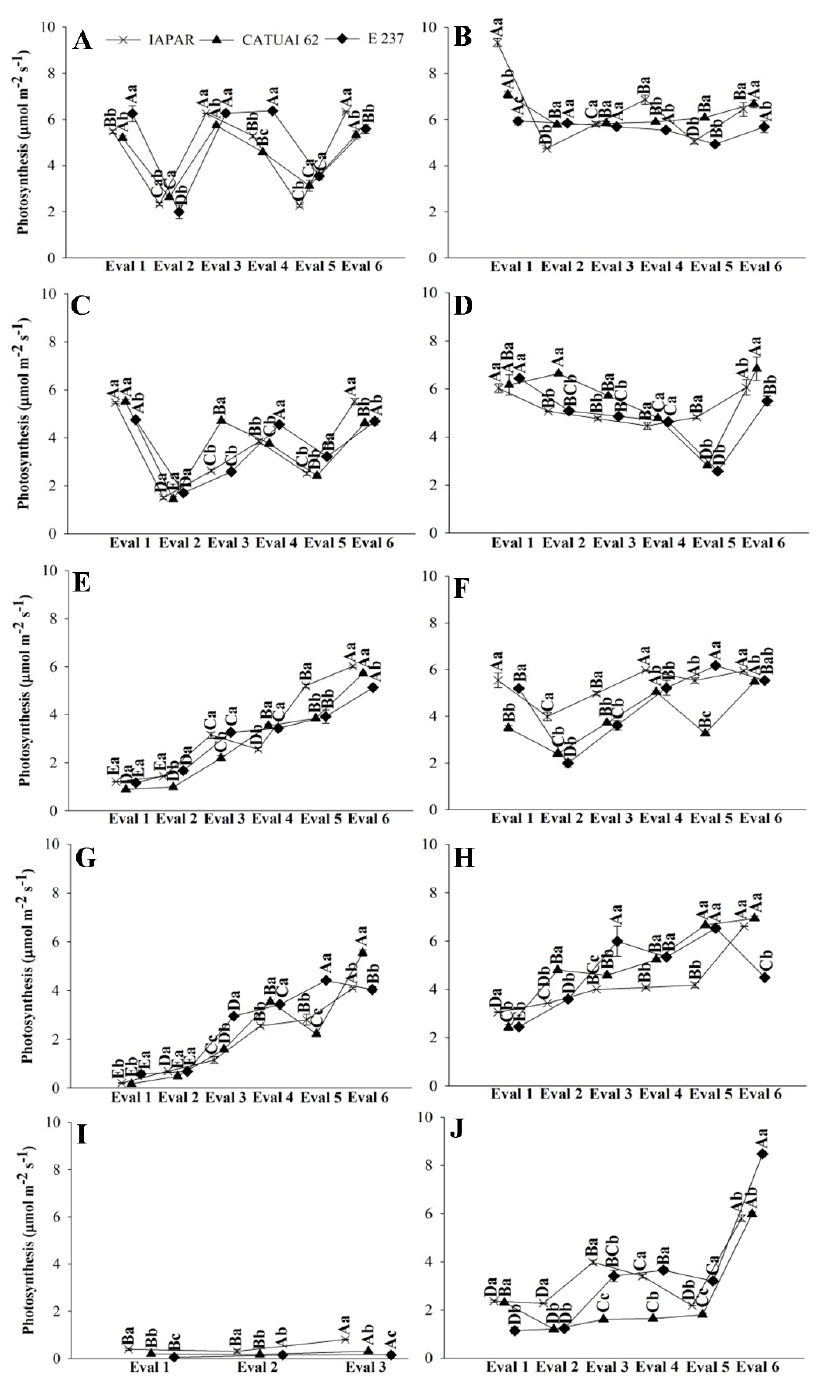
Figure 3. Photosynthetic rate of coffee leaves under water stress (Eval 1) and after the return of irrigation (Eval 2 to 6), in 2019 and 2020, of three genotypes of arabica coffee (Iapar 59, Catuaí 62 and E237) subjected to five water regimes (FI 100 ( A , B ), FI 50 ( C , D ), WD 100 ( E , F ), WD 50 ( G , H ) and rainfed ( I , J )). Capital letters compare the water regimes for each cultivar and lowercase letters compare the cultivars of each water regime. Means followed by the same letter do not differ according to the Tukey test at 5% probability. FI 100 and 50 (full irrigation with 100% and 50% replacement of evapotranspiration); WD 100 and 50 (water deficit with the suspension of irrigation from June to September, with replacement of 100% and 50% of evapotranspiration, respectively); rainfed (without irrigation).